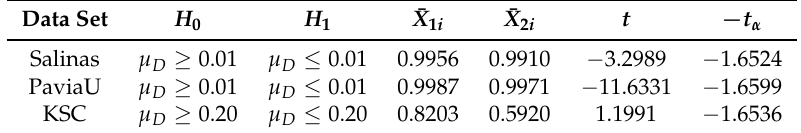
Table 4. The results of the paired sample t -test, in which the significance level is 95% (i.e., α = 0.05). Data